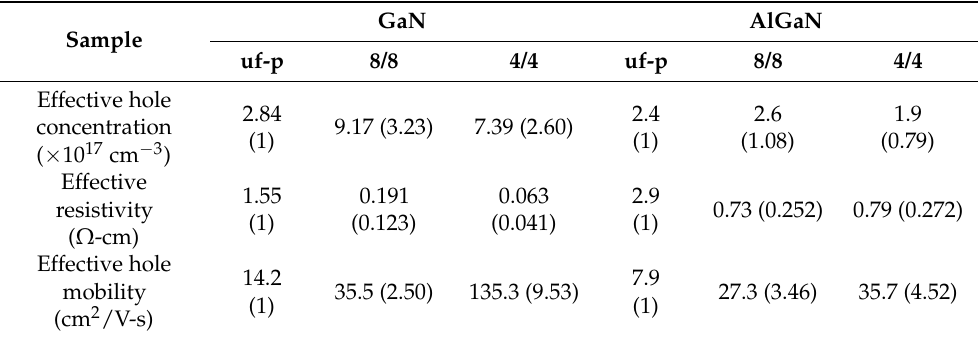
Table 2. Comparison of the results of effective hole concentration, effective resistivity, and effective hole mobility of samples uf-p, 8/8, and 4/4 between GaN and AlGaN.